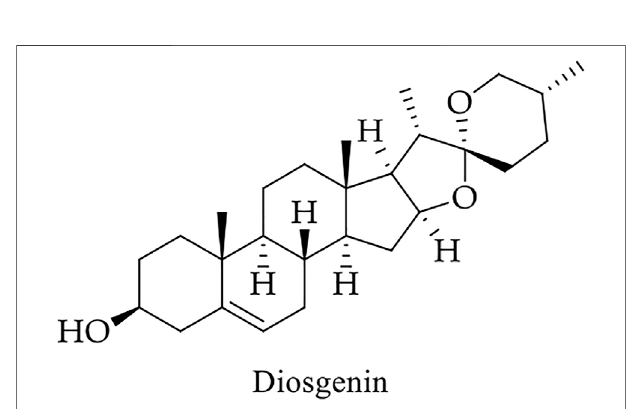
FIGURE 11 | Chemical structure of the chemopreventive bioactive compound of fenugreek.